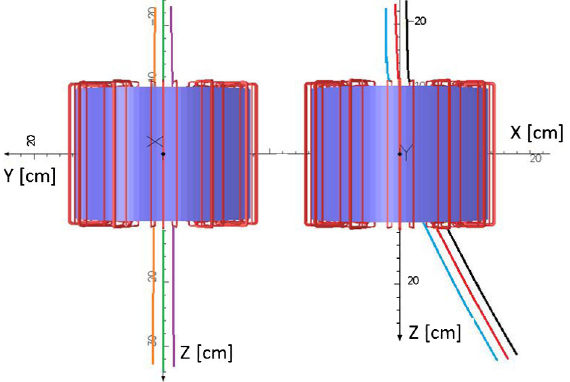
FIG. 5. Electrons’ trajectories in the combined dipole and quadrupole fields.